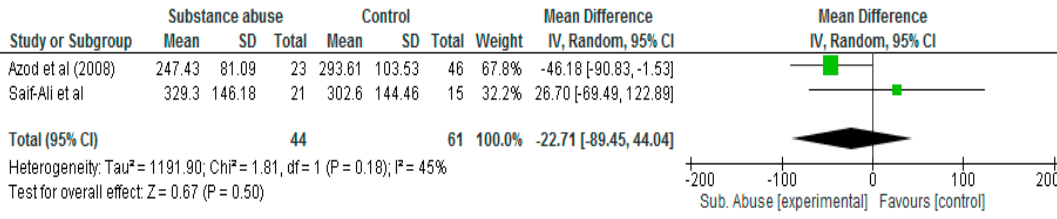
Figure 5. Results of Postprandial Blood Glucose (mg/dL).